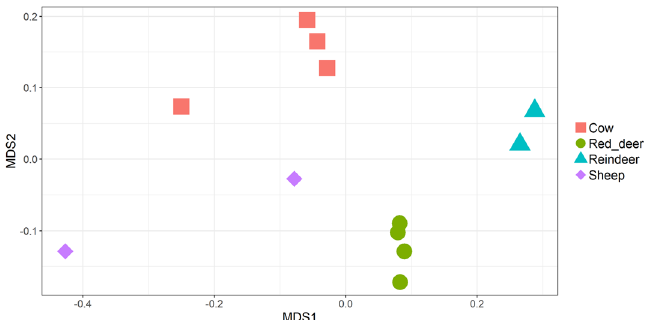
Figure 7. NMDS of ruminal samples clustered by abundance of KEGG orthologs, using Bray–Curtis dissimilarity values (PERMANOVA; P =